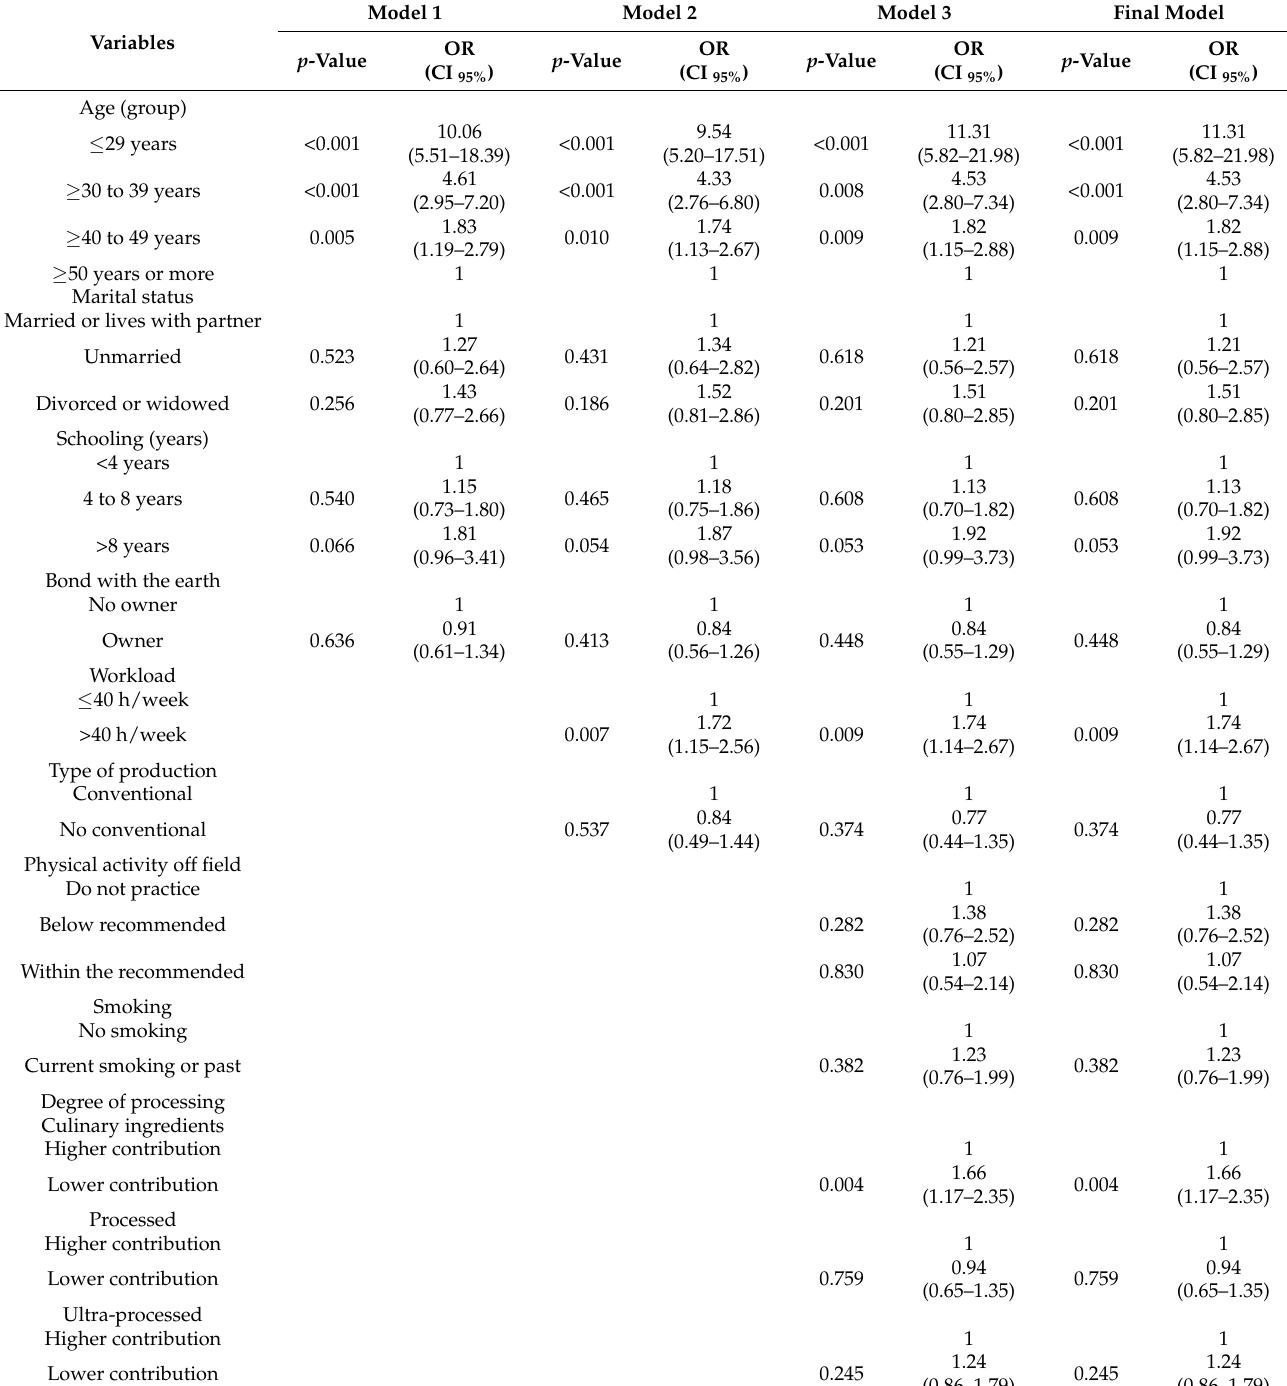
Table 3. Hierarchical logistic regression between the associated variables in the bivariate analysis and the conicity index according to the components of the